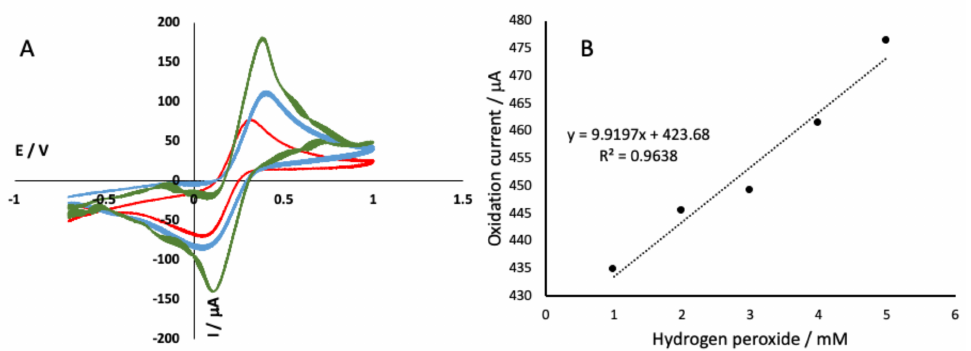
Figure 2. Electron transfer behavior of a bare glassy carbon electrode ( A , blue line), alginate cryogel modified electrode ( A , red line), and alginate-NiFe 2 O 4 nanoparticles cryogel modified electrode ( A , green line) measured on 10 mM potassium ferricyanide. Alginate-NiFe 2 O 4 nanoparti- cles modified electrode showed a linear response for detecting hydrogen peroxide ( B